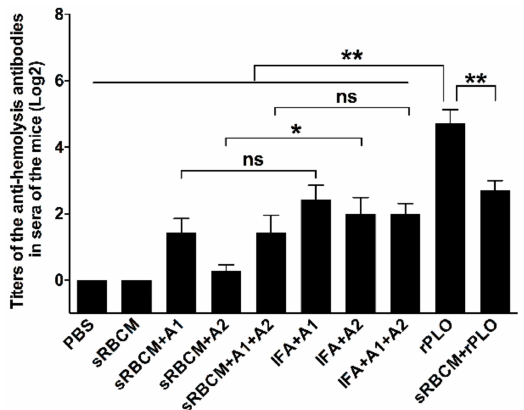
Figure 5. Titers of anti-hemolysis antibody in sera of immunized mice. Sera of rPLO immunized mice showed the highest level of anti-hemolysis antibody in all sera. Compared with the sera that were collected from mice received sRBCM-trapped tPLOA2 (A2), sera from mice received IFA emulsified tPLOA2 showed a significantly higher level of anti-hemolysis antibody. One-way ANOVA test was performed. (* p < 0.05; ** p < 0.05; ns: not